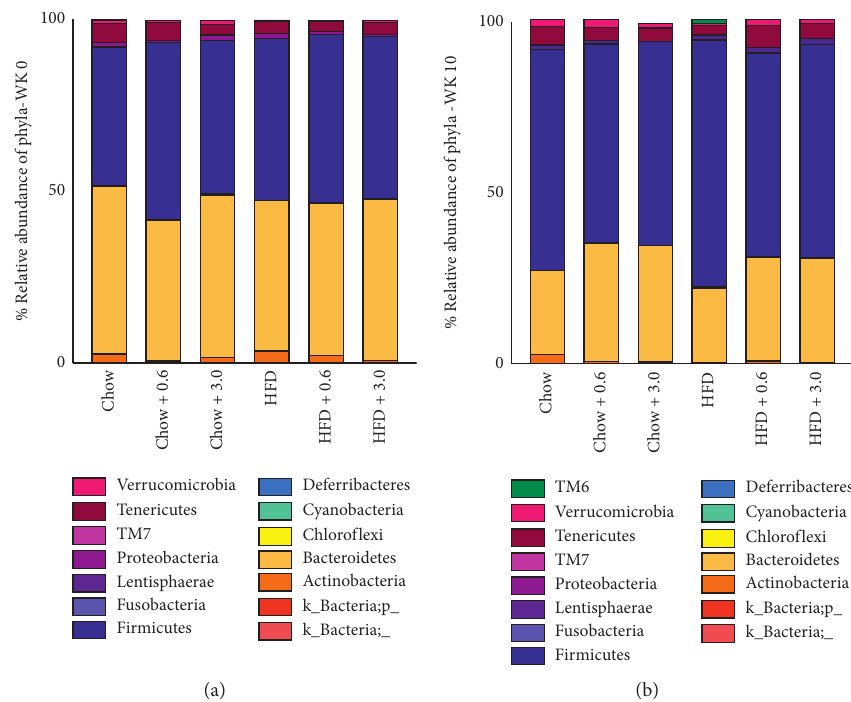
Figure 9: Average percent relative abundance of phyla. (a) Relative abundance of microflora at phylum level in fecal samples of each group at week 0. Data were analyzed by one-way ANOVA followed by Bonferroni post hoc test found no significant differences between groups ( n � 5-6/group). 14 phyla were identified. (b) Relative abundance of microflora at phylum level in fecal samples of each group at week 10. Data were analyzed by one-way ANOVA followed by Bonferroni post hoc test found no significant differences between groups ( n � 5-6/ group). 15 phyla were identified.